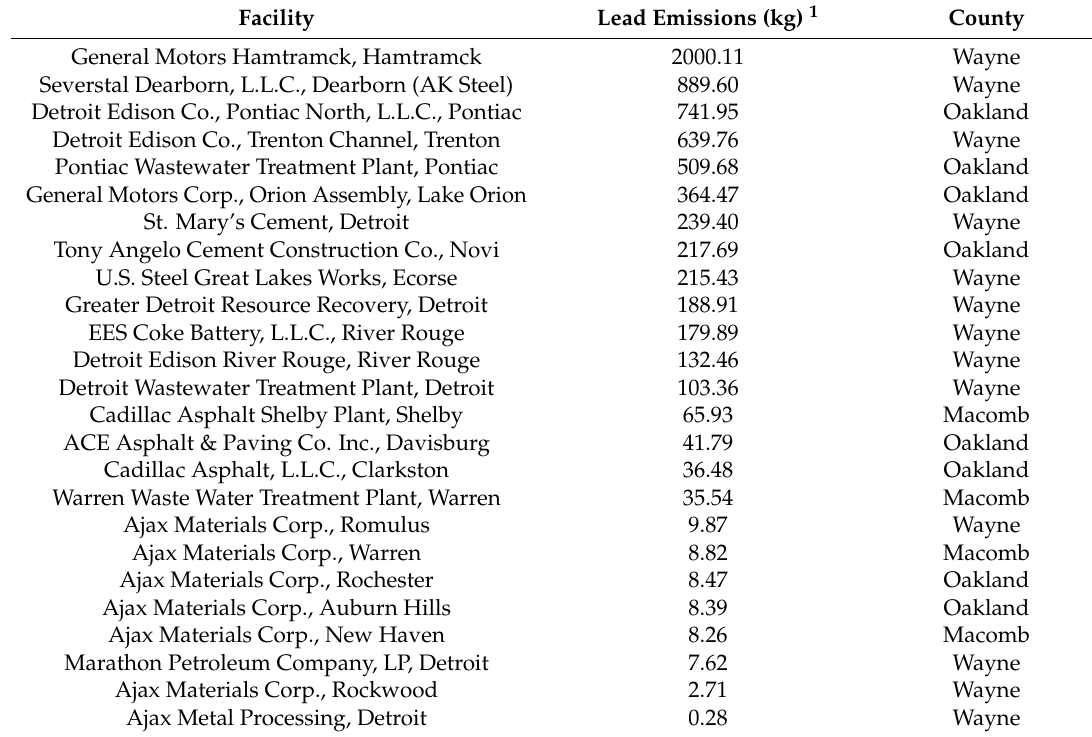
Table 3. Largest lead emitters in the Detroit Metropolitan Area by county, 2006–2013.